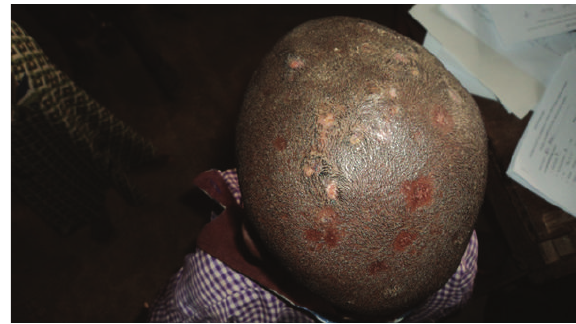
Figure 1: Tinea capitis with scarring alopecia.